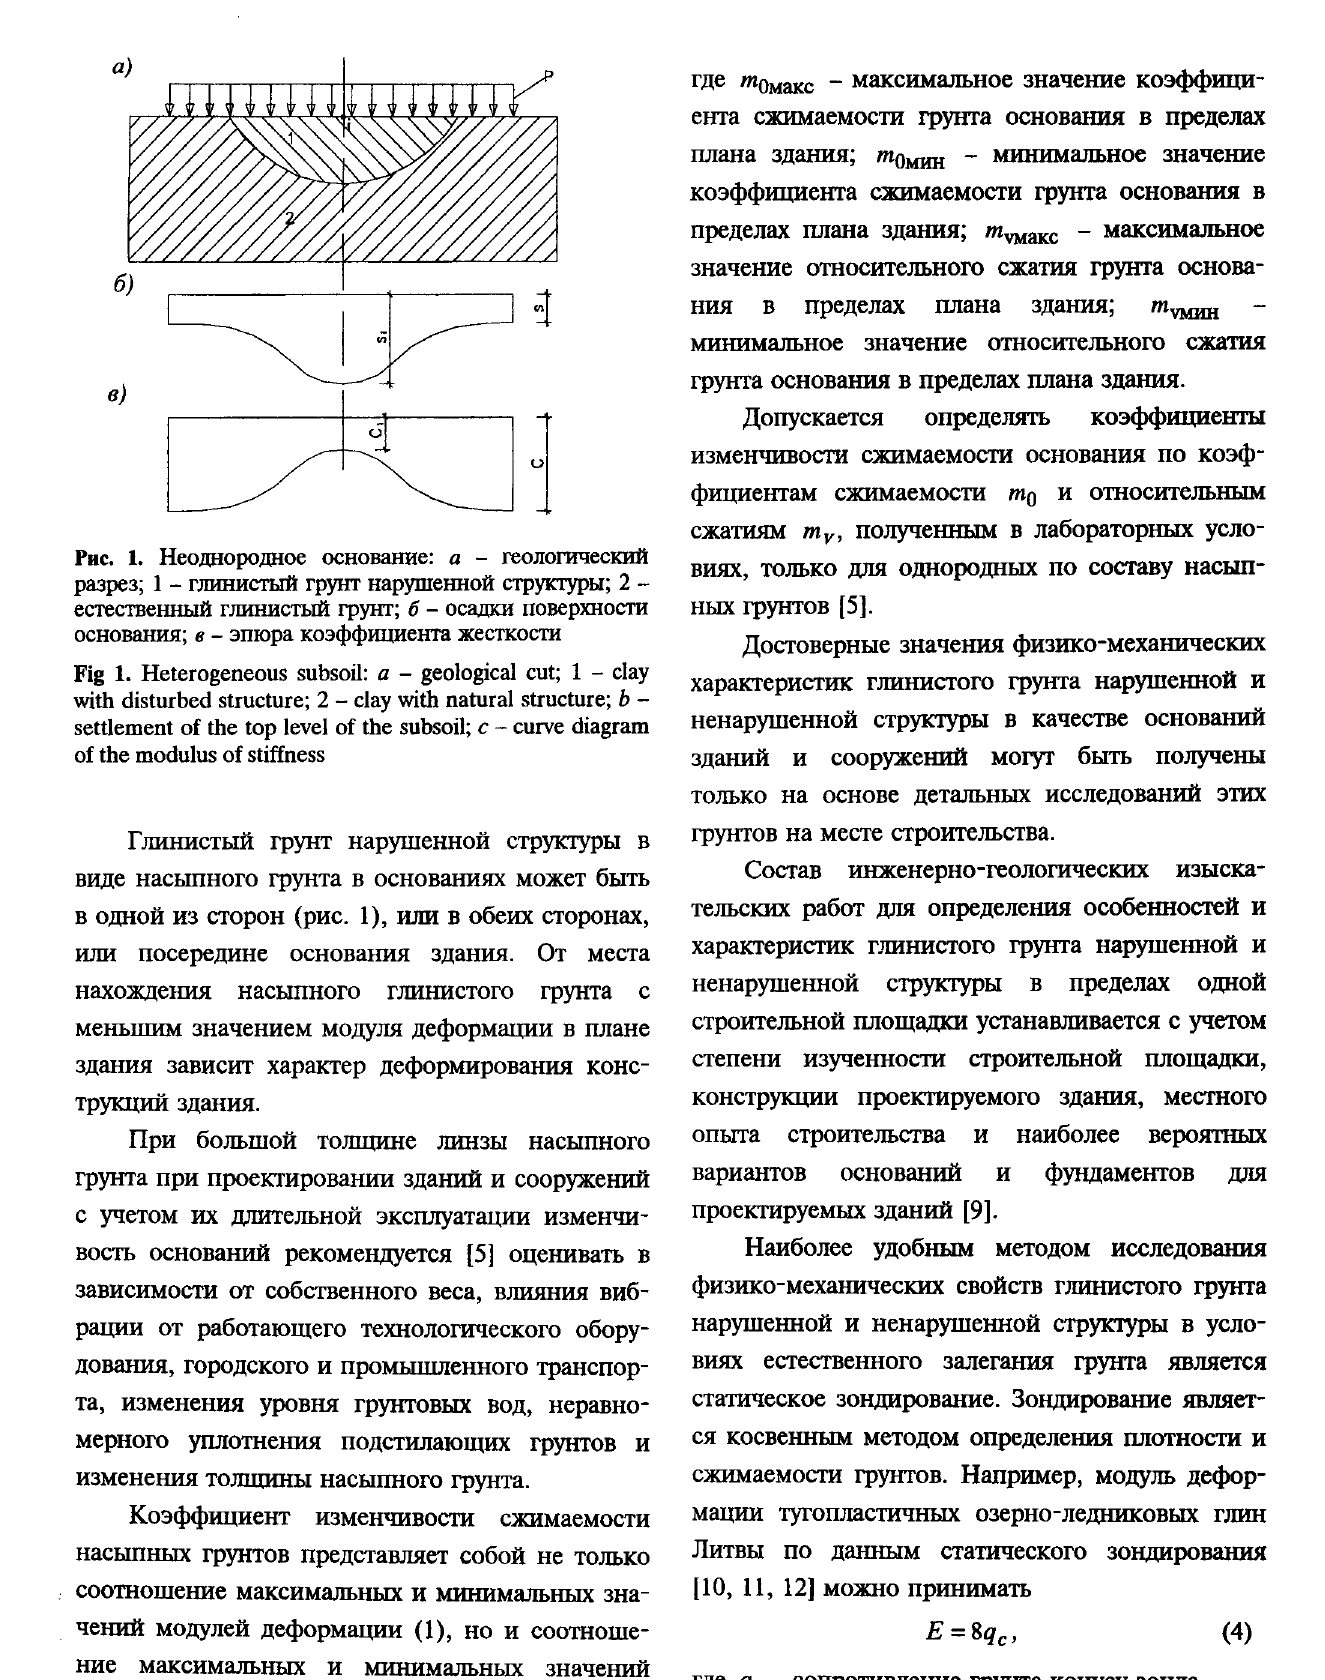
OCHOBiliiiDI; 8 - 3UIOpa K03cjJcjJHUHeHTa XeCTKOCTH Fig 1. Heterogeneous subsoil: a - geological cut; 1 - clay with disturbed structure; 2 - clay with natural structure; b - settlement of the top level of the subsoil; c - curve diagram of the modulus of stiffness